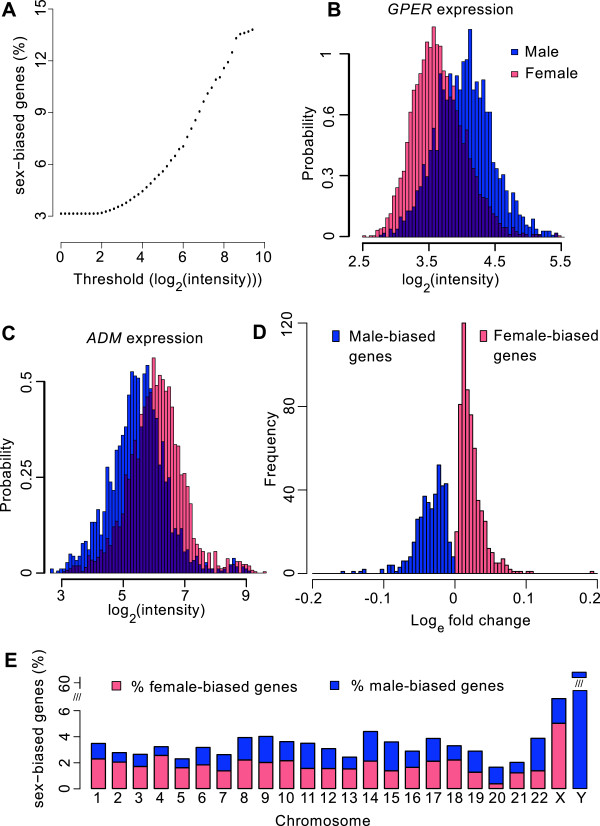
Characterization of female- and male-biased genes. For each of the 47,122 transcripts the sex effect was determined using a mixed model, resulting in 3.1% sex-biased genes. A) Transcripts were selected based on a threshold for mean expression, the percentage of sex-biased genes increases with the threshold that is used: in genes that are highly expressed there are more (up to 13%) sex-biased genes than in genes that have low expression. Nonetheless, also large male/female fold changes were observed in genes with low (B) and moderate (C) expression. D) For each transcript fold changes were computed; on the autosomes 57.7% of the sex-biased genes was female-biased, and absolute loge fold changes ranged from 0 to 0.2. E) For each chromosome, the number of male- and female-biased genes was computed, only the Y and X chromosomes were enriched for male- and female-biased genes, respectively.